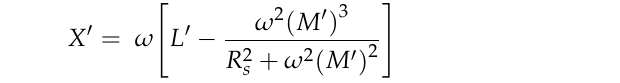
Table 2. Main characteristics of the MV underground cable.